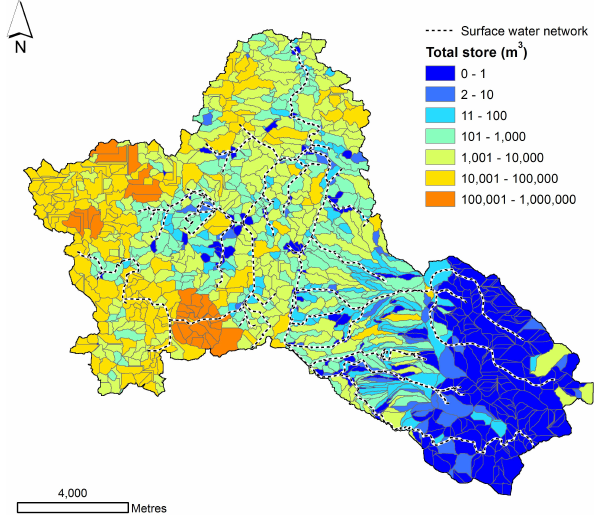
Fig. 5. Stream network and retention volumes in identified surface